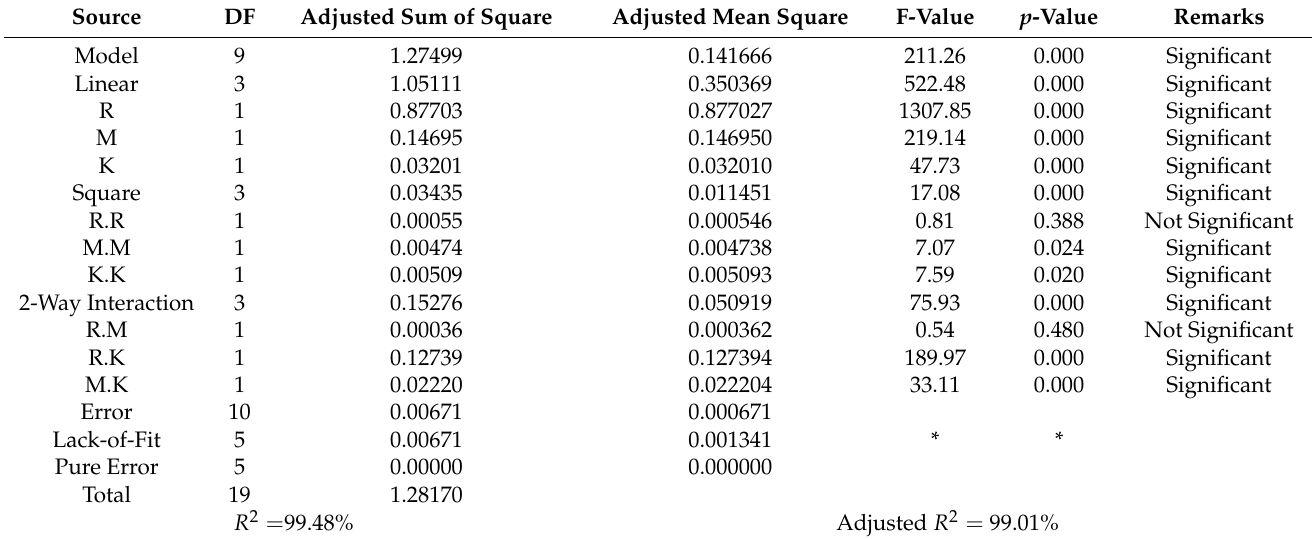
Table 5. ANOVA for Cf x ( − 1 ) .